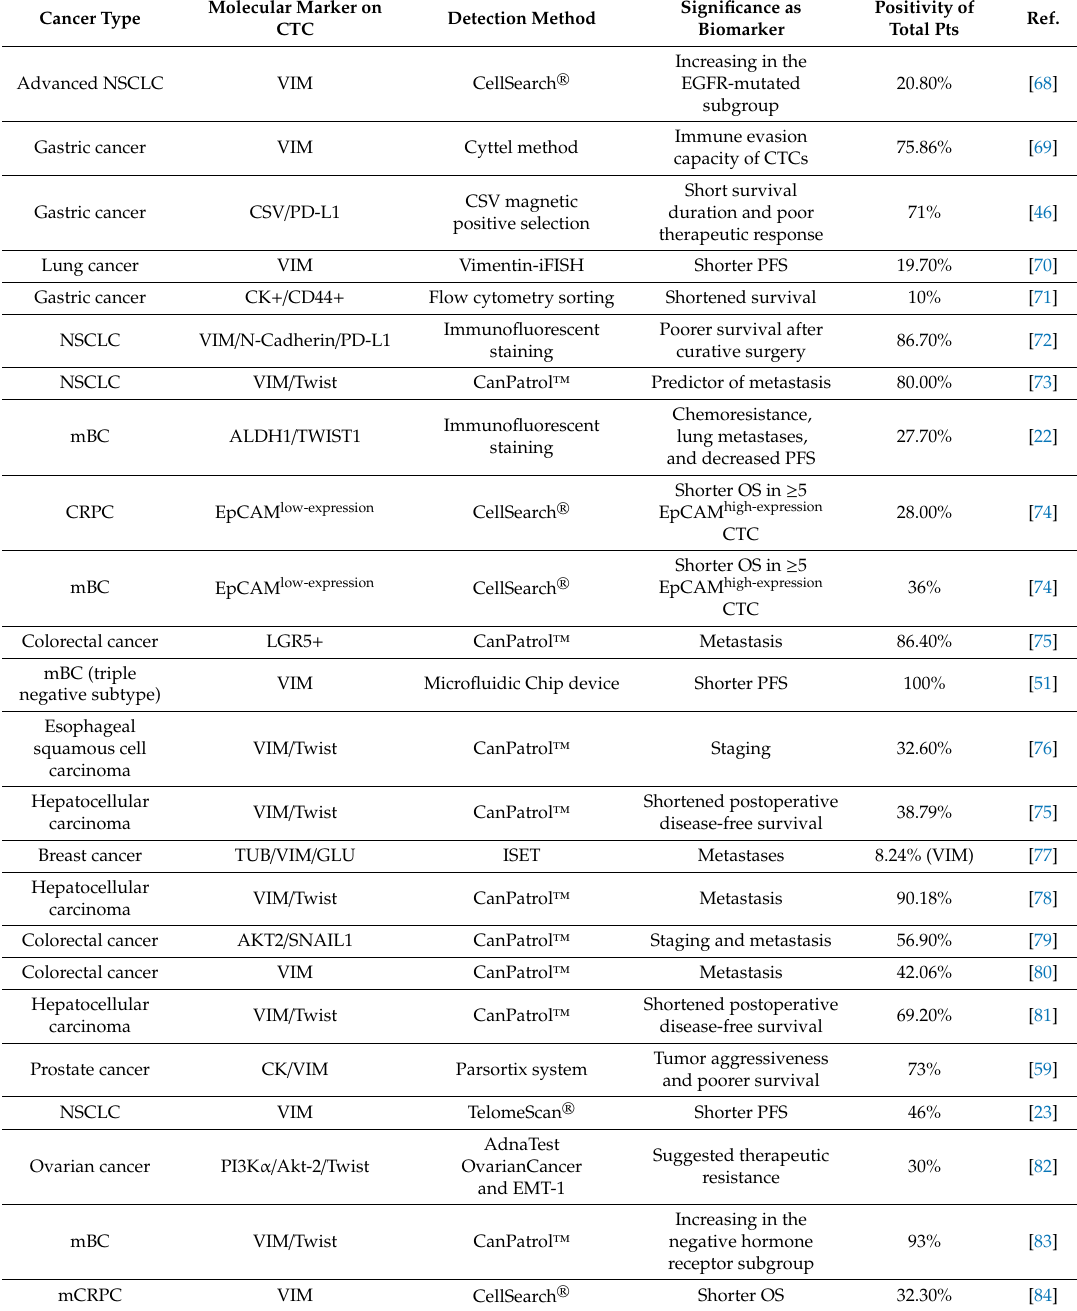
Table 1. Mesenchymal markers expressed on circulating tumor cells (CTCs) from patients with di ff erent tumor types and clinical significance as surrogate